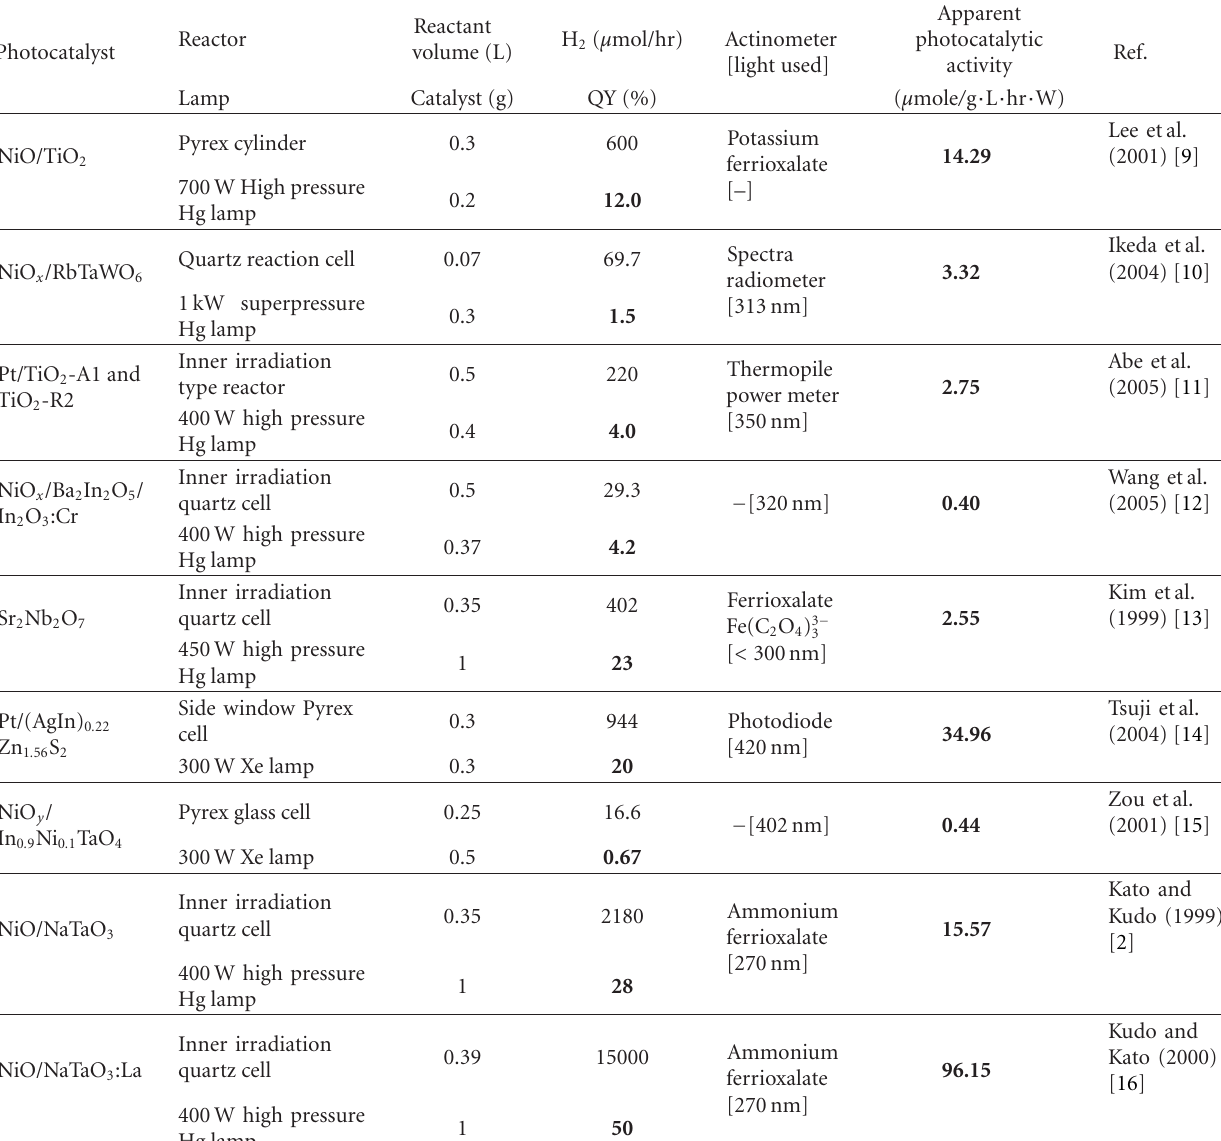
Table 3: Quantum yield (QY) obtained by (1) and apparent photocatalytic activity (APA) obtained by (2) of several semiconductor pho- tocatalysts for water splitting.